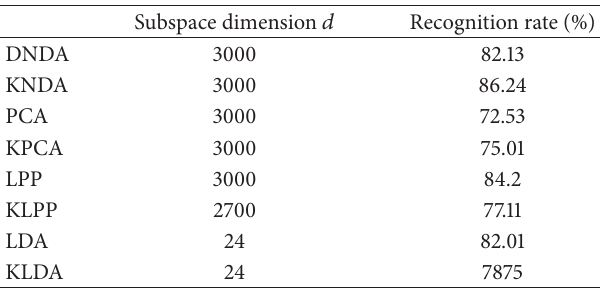
Table 3: The best recognition rate achieved by each method along with the corresponding subspace dimension 𝑑